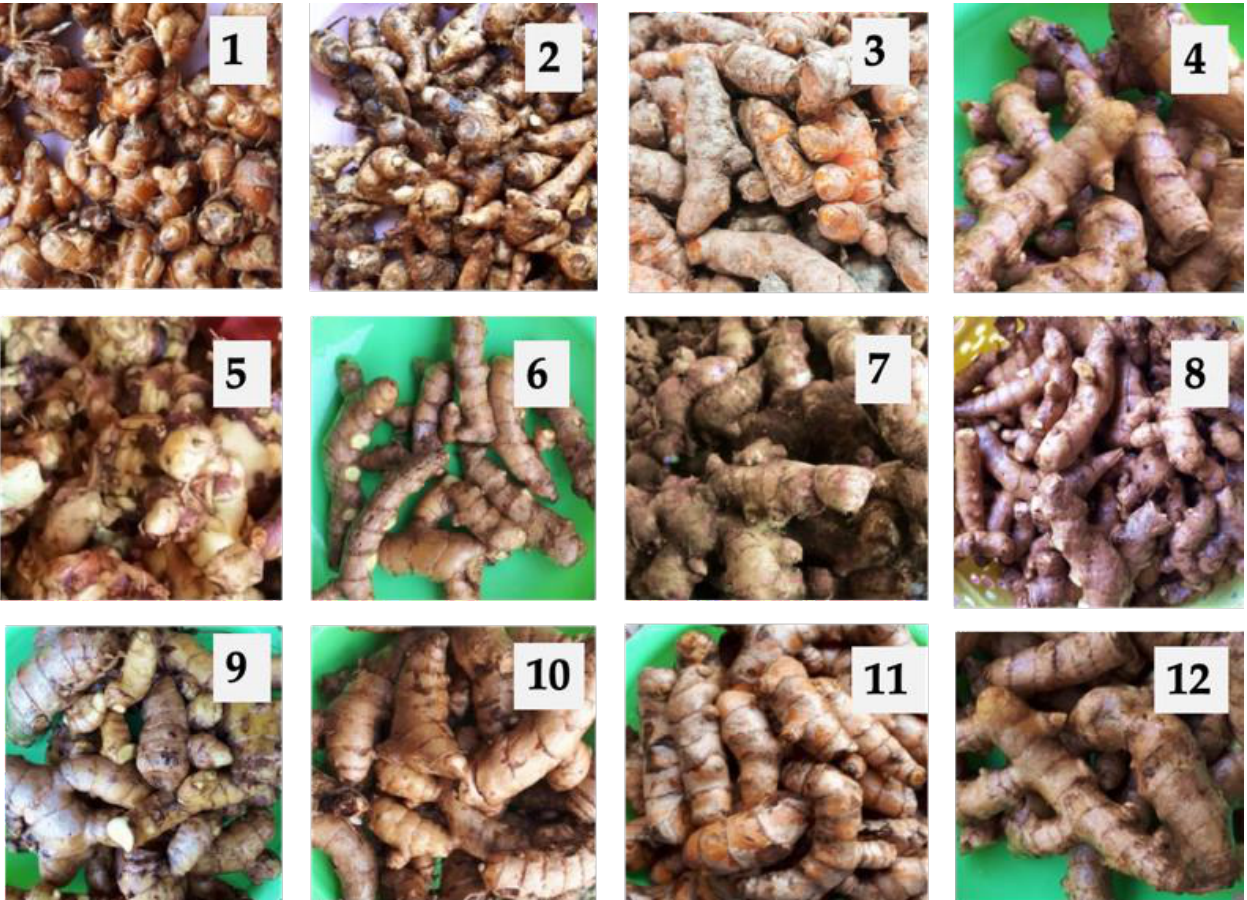
Figure 1. The rhizome part of 12 Indonesian indigenous Zingiberaceae species herbs: (1) K. galanga , (2) B. rotunda , (3) C. longa , (4) Z. cassoumounar , (5) C. heynana , (6) A. purpurata , (7) Z. officinale , (8) Z. zerumbet , (9) C. manga , (10) C. aeruginosa , (11) C. xanthorrhiza , and (12) C. zedoaria.